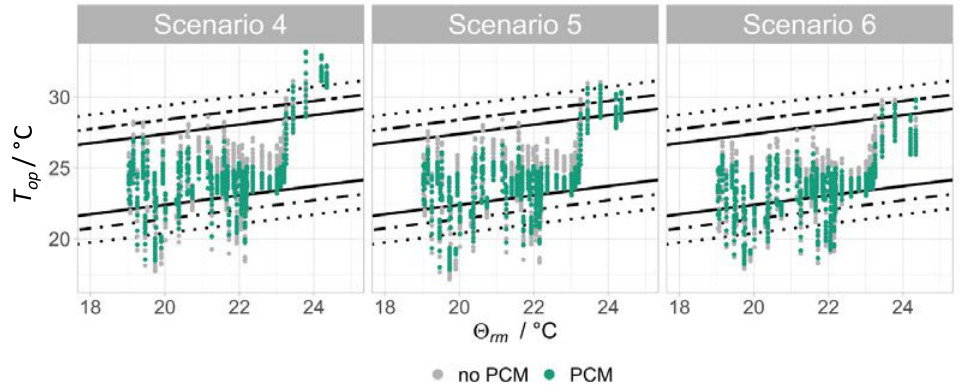
Figure 12. Comfort diagrams with simulated T op of the three different behavioural scenarios for classroom. Black lines indicate different comfort categories: solid = Category I—high standard, dot-dashed = category II—middle standard, dotted = category III—moderate standard.